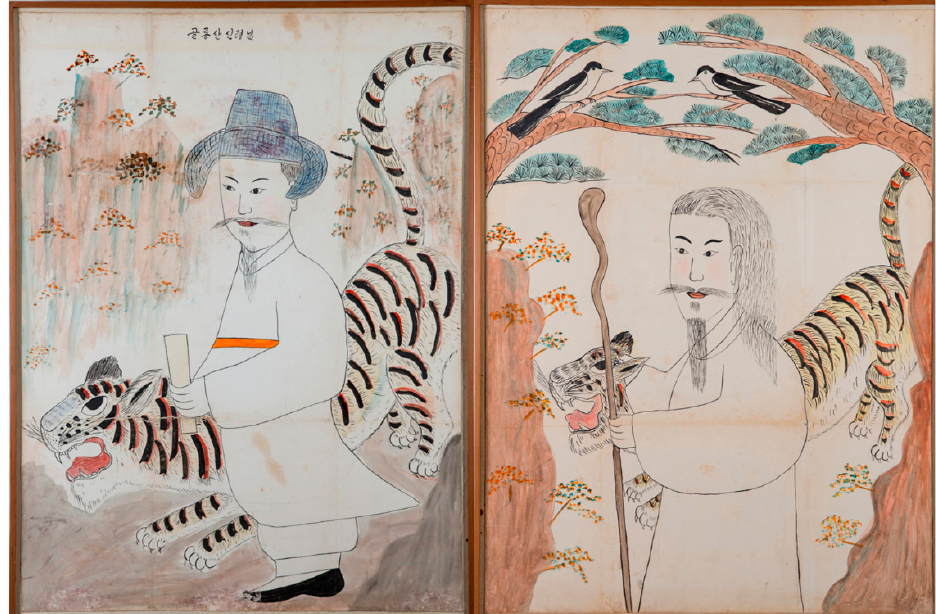
Figure 8. Mountain God paintings are now conventionalized images but these two old images, probably by the same hand, reveal distinctive visions of different Gods on different mountains, early- to mid-20th-century. Museum of Shamanism, photograph by Jongsung Yang. to mid-20th-century. Museum of Shamanism, photograph by Jongsung